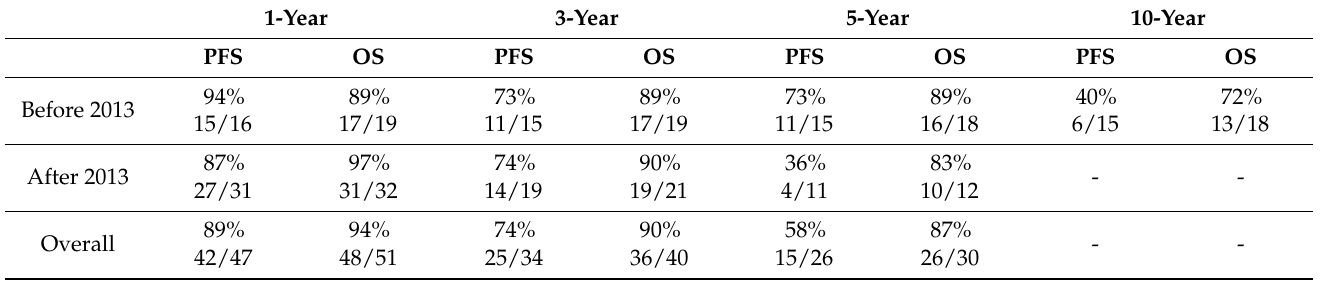
Table 6. The rate of progression ‐ free survival (PFS) and overall survival (OS) between the two time periods.